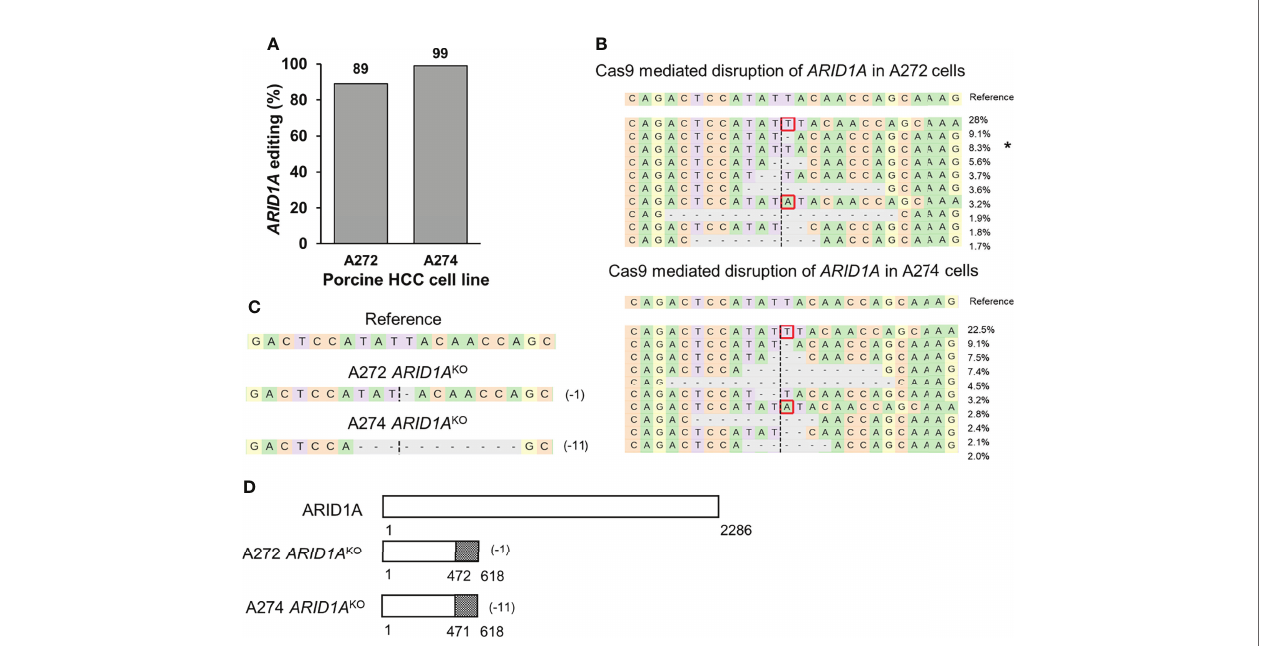
FIGURE 4 | Generation of ARID1A KO porcine HCC cells by CRISPR/Cas9. (A) CRISPR/Cas9-induced editing of ARID1A in A272 and A274 porcine HCC cells. Genomic DNA was collected two days post-transfection and analyzed by targeted NGS. The bar graph depicts the percentages (%) of total reads that displayed indels at the gRNA target site. (B) Top 10 reads detected by targeted NGS analysis in the two porcine HCC lines mapped to the reference sequence. The percentage of reads of each sequence are shown on the right. The asterisk (*) indicates/marks non-edited reads. Dashed line, predicted Cas9 cleavage position; red box, insertion; dash, deleted base. (C, D) Analysis of ARID1A KO single cell clones isolated from A272 and A274 porcine HCC cells transfected with Cas9 and ARID1A gRNA. (C) Reads detected by targeted NGS analysis mapped to the reference sequence for A272 and A274 ARID1A KO cells. Dashed line, predicted Cas9 cleavage position; red box, insertion; dash, deleted base. (D) Schematic representation of predicted translation of ARID1A protein in the isolated ARID1A KO HCC cells. The dotted region represents amino acids with frameshift